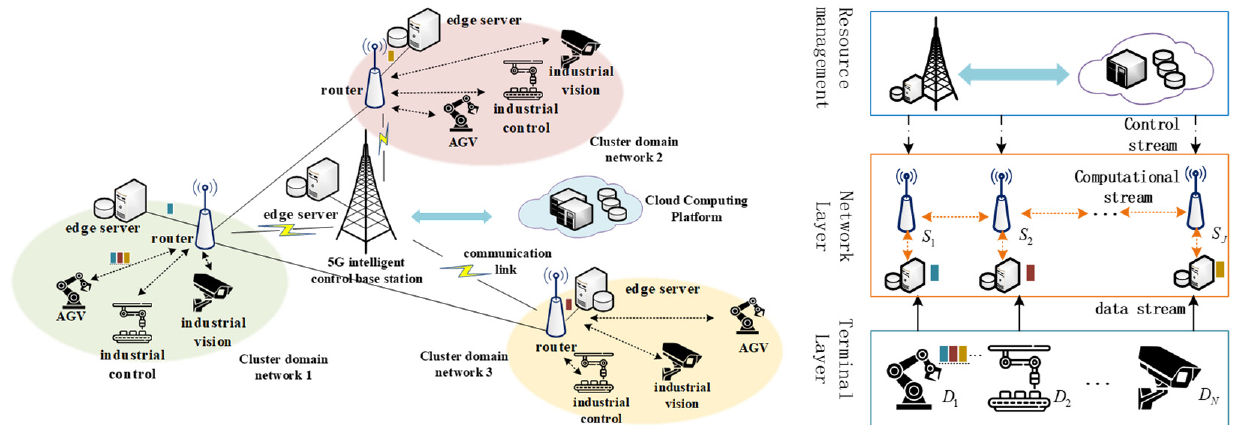
Figure 1. System model for task-offloading and resource allocation.